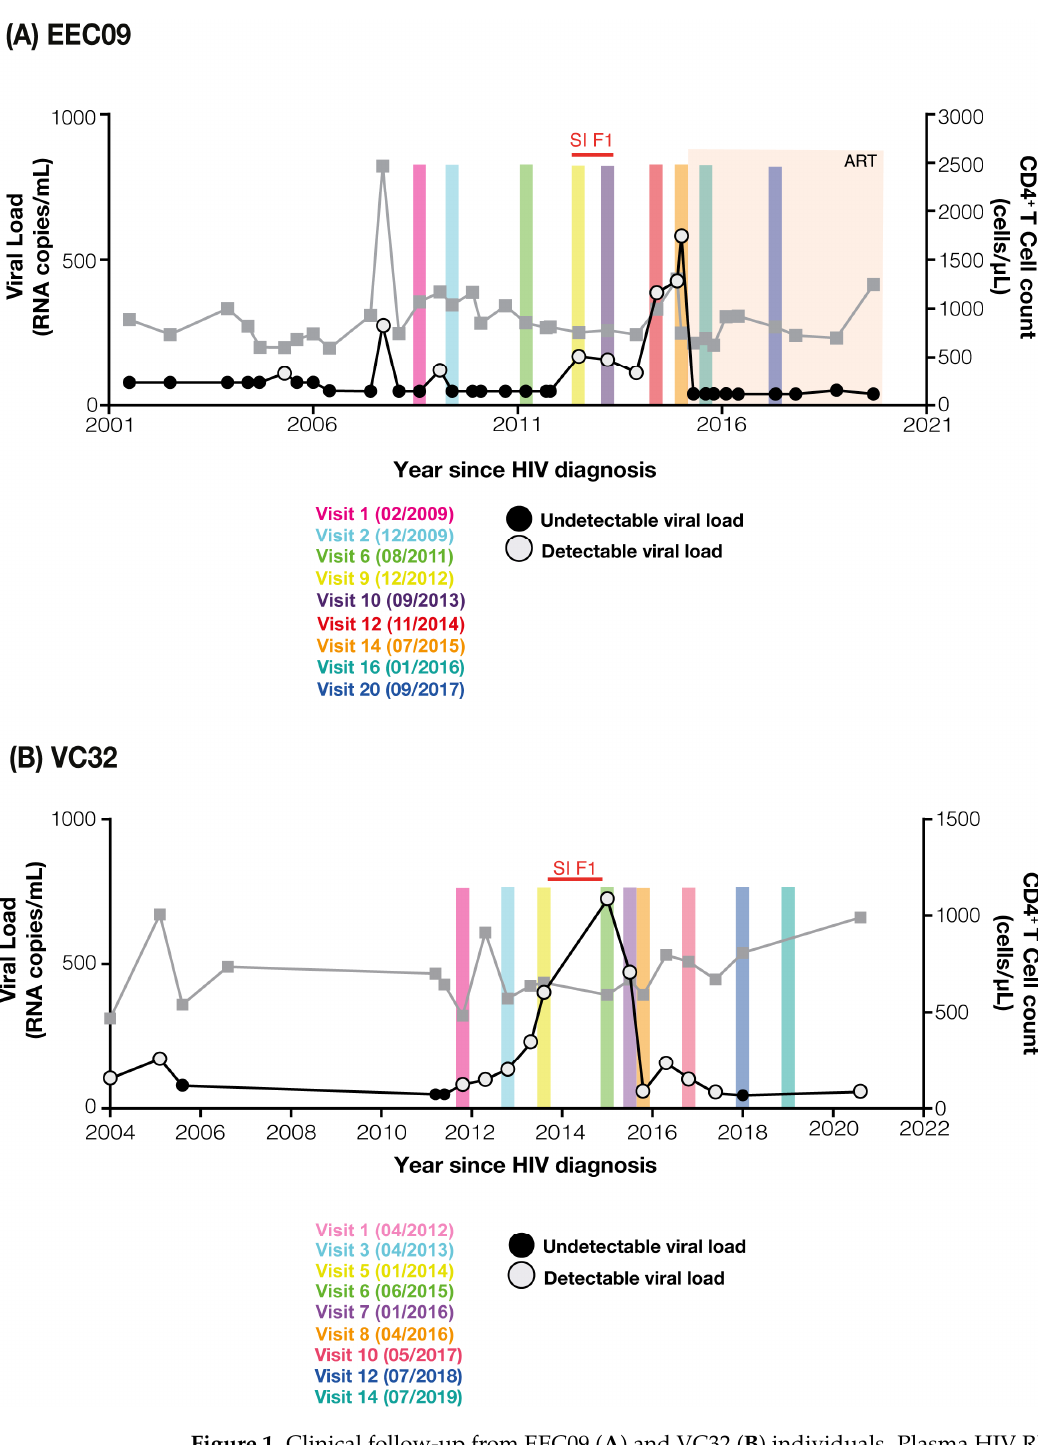
Figure 1. Clinical follow-up from EEC09 ( A ) and VC32 ( B ) individuals. Plasma HIV RNA viral load (copies/mL, circles) and CD4 + T cell counts (cells/µL, squares) since HIV diagnosis of individuals EEC09 and VC32 are shown on the left and the right Y-axis, respectively. HIV RNA viral load measurements after the start of combined antiretroviral therapy (ART) are highlighted in the beige frame. The range of superinfection (SI) with the F1 variant of HIV-1 is highlighted in red. Colored shaded areas indicate the time points (visit, month/year) selected for the DNA quasispecies analysis.